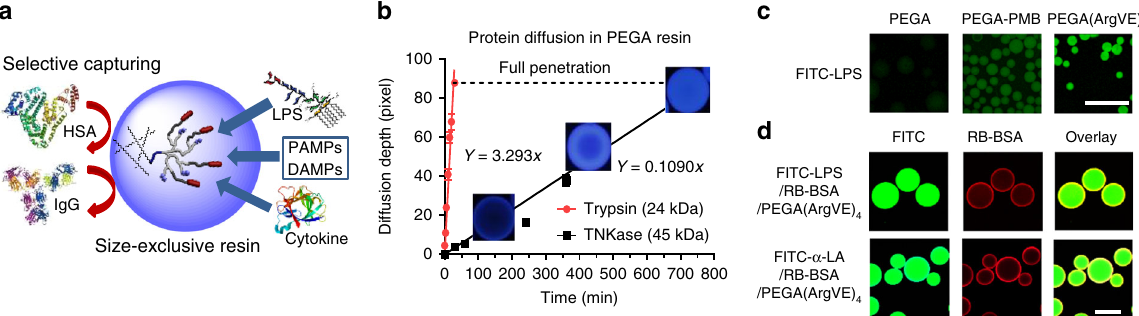
Fig. 2 TD NT resins for selective adsorption based on size effects. a Schematic representation of selective LPS and cytokine removal by nanotrap- immobilized size-exclusive resin. b Kinetic diffusion of proteases Trypsin (24 kDa) and TNKase (45 kDa) in PEGA resins conjugated with the corresponding substrates: beads become fl uorescent upon substrate cleavage by enzymes releasing the quencher (nitrotyrosine) from the fl uorescent dye (Abz) (see Supplementary Fig. 9). c Fluorescent microscopy images showing the adsorption of FITC-LPS by blank PEGA, PEGA-PMB, and PEGA-(ArgVE) 4 resins (scale bar: 500 µ m). d Confocal images of PEGA-(ArgVE) 4 resins incubated with the mixture of FITC-LPS or FITC- α -LA with RB-BSA (1:100 mass ratio), indicating the effective penetration of smaller LPS and α -LA and restriction of larger BSA binding on the surface of resin (scale bar: 100 µ m). c , d Repeated independently a minimum of